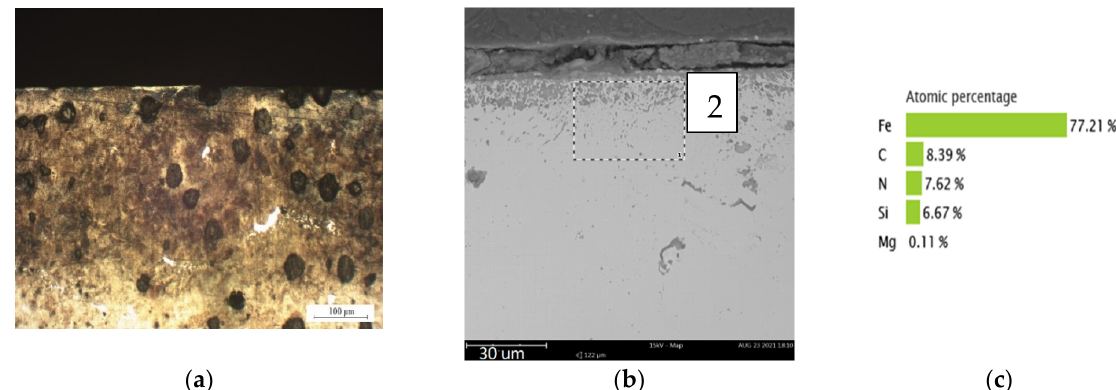
Figure 11. Nitrided layer of spheroidal graphite iron that meets the requirements of the technological process: ( a ) layer microstructure, hardness 552–603 HV5, depth 0.31 mm; ( b ) SEM image, measured area (2); ( c ) histogram of the elemental composition of area 2.